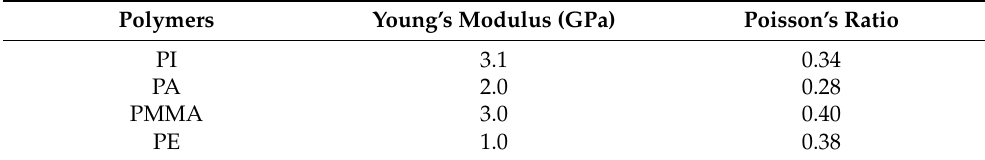
Table 1. Young ’ s modulus and Poisson ’ s ratio of common polymer materials.